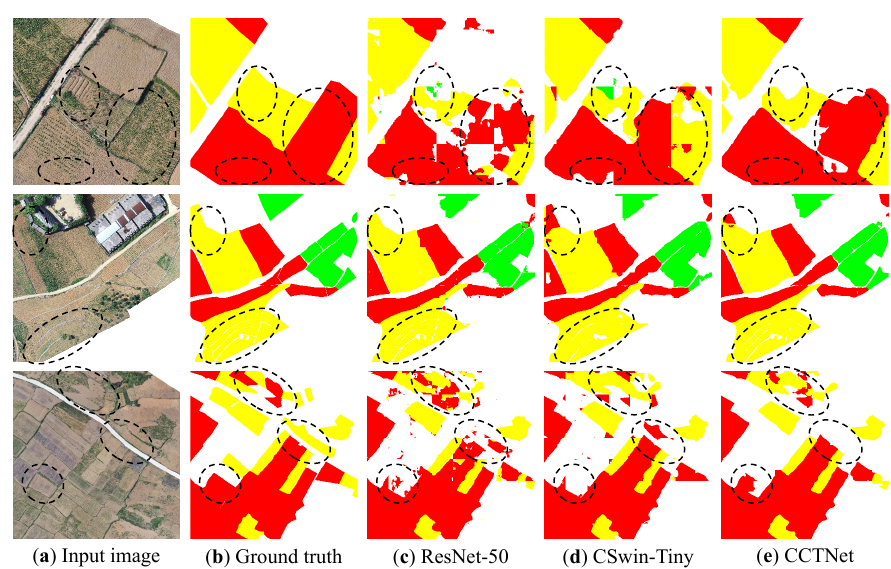
Figure 12. Comparison of the improvements of each method.